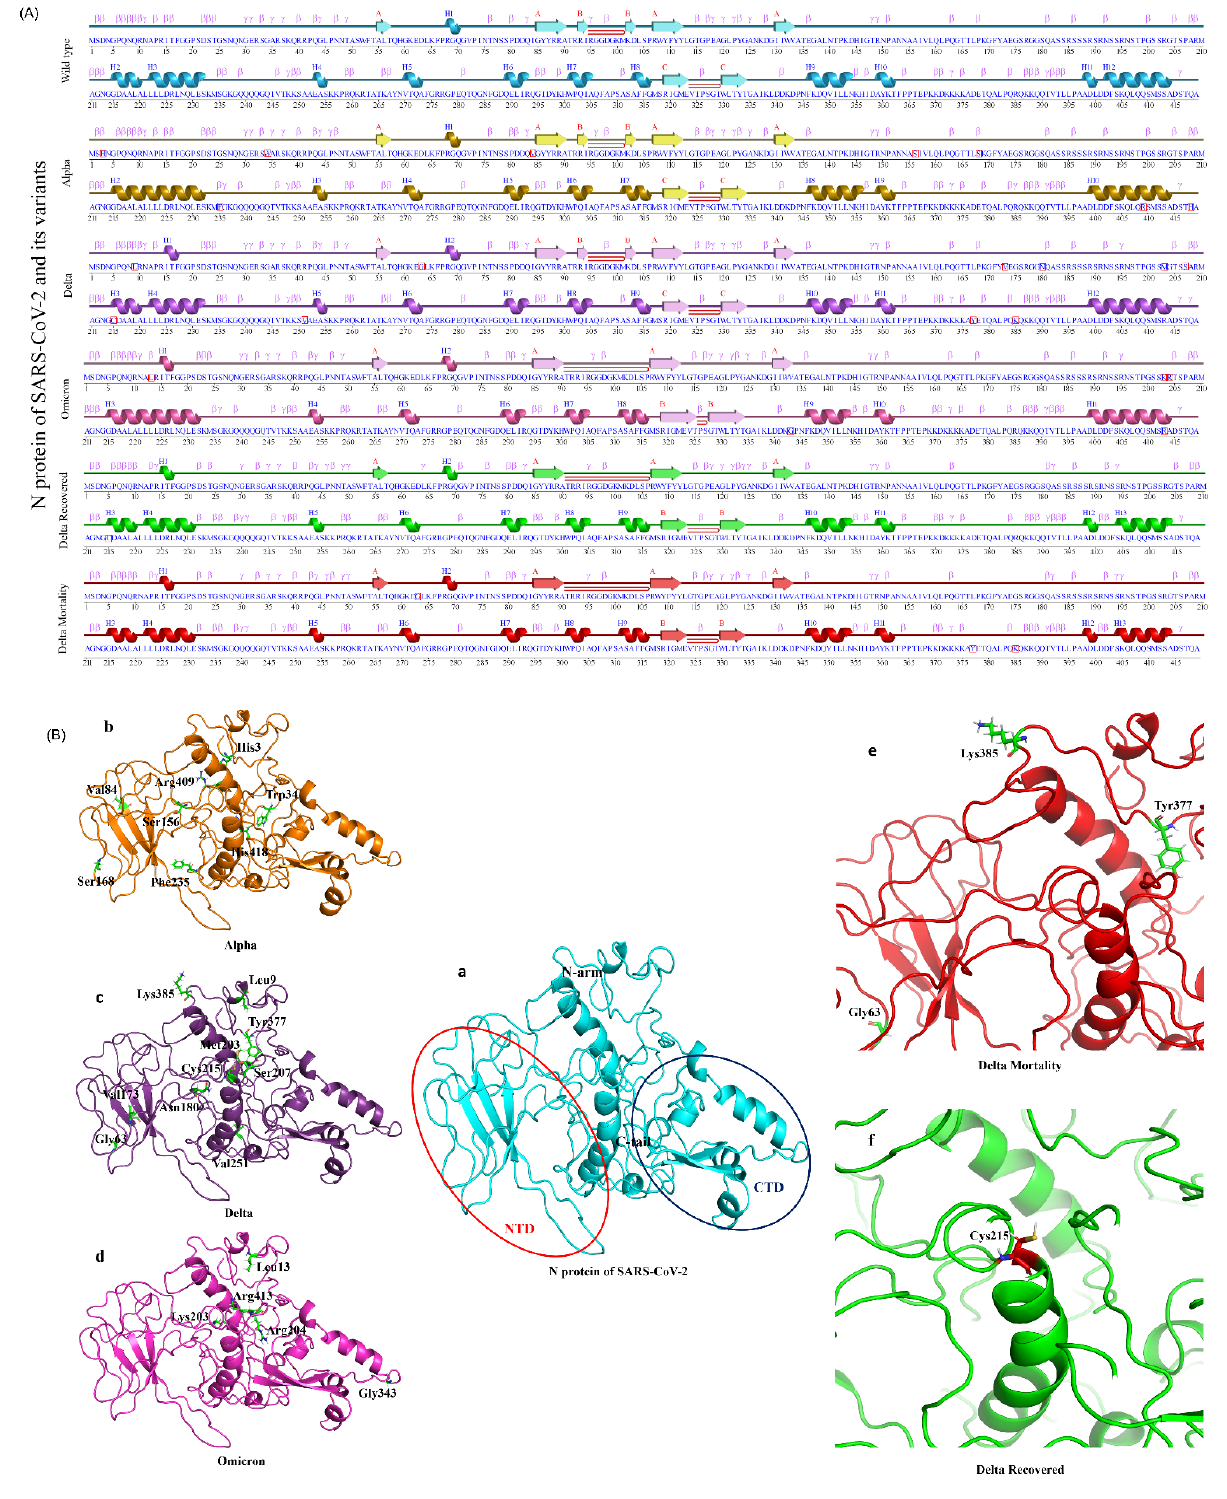
Figure 6. 2D and 3D structural changes in the N protein with respect to the variants and their clinical outcomes. ( A ) Secondary structure representation of the targeted N protein and its variants, along with the “ (cid:3) ” represents the mutated amino acid(s). ( B ) Molecular modeling of the N protein wild type ( a ) (Red circle represents the NTD domain and the dark blue color represents the CTD domain), Alpha ( b ), Delta ( c ), Omicron ( d ), DM ( e ), and DR ( f